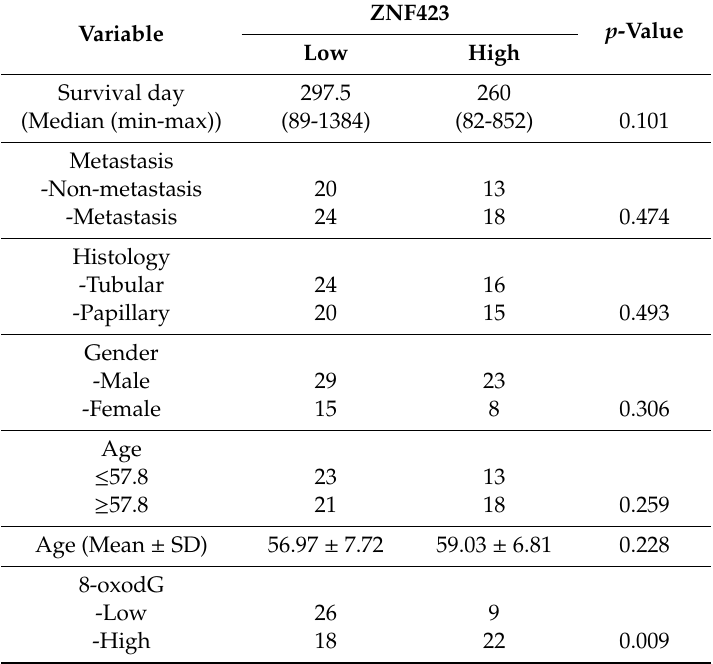
Table 1. Correlation between ZNF423 expression levels in cholangiocarcinoma (CCA) tissues and clinico-pathological data of CCA patients and 8-oxodG